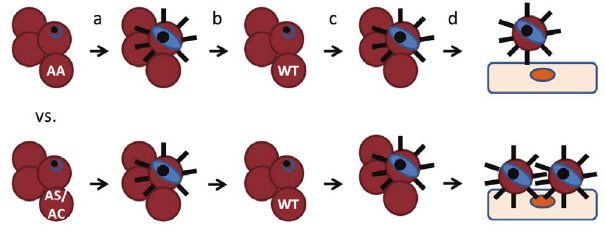
Figure 1. Schematic representation of the cytoadherence assay. Ring-stage parasites from HbAA and HbAS (or HbAC) children were cultured to trophozoites (a), and then purified by magnetic column and inoculated into wildtype donor RBCs (b). After invasion and maturation to trophozoites expressing PfEMP1 (c), parasites from HbAS or HbAC children were compared for binding to MVECs in parallel with those from HbAA children (d).